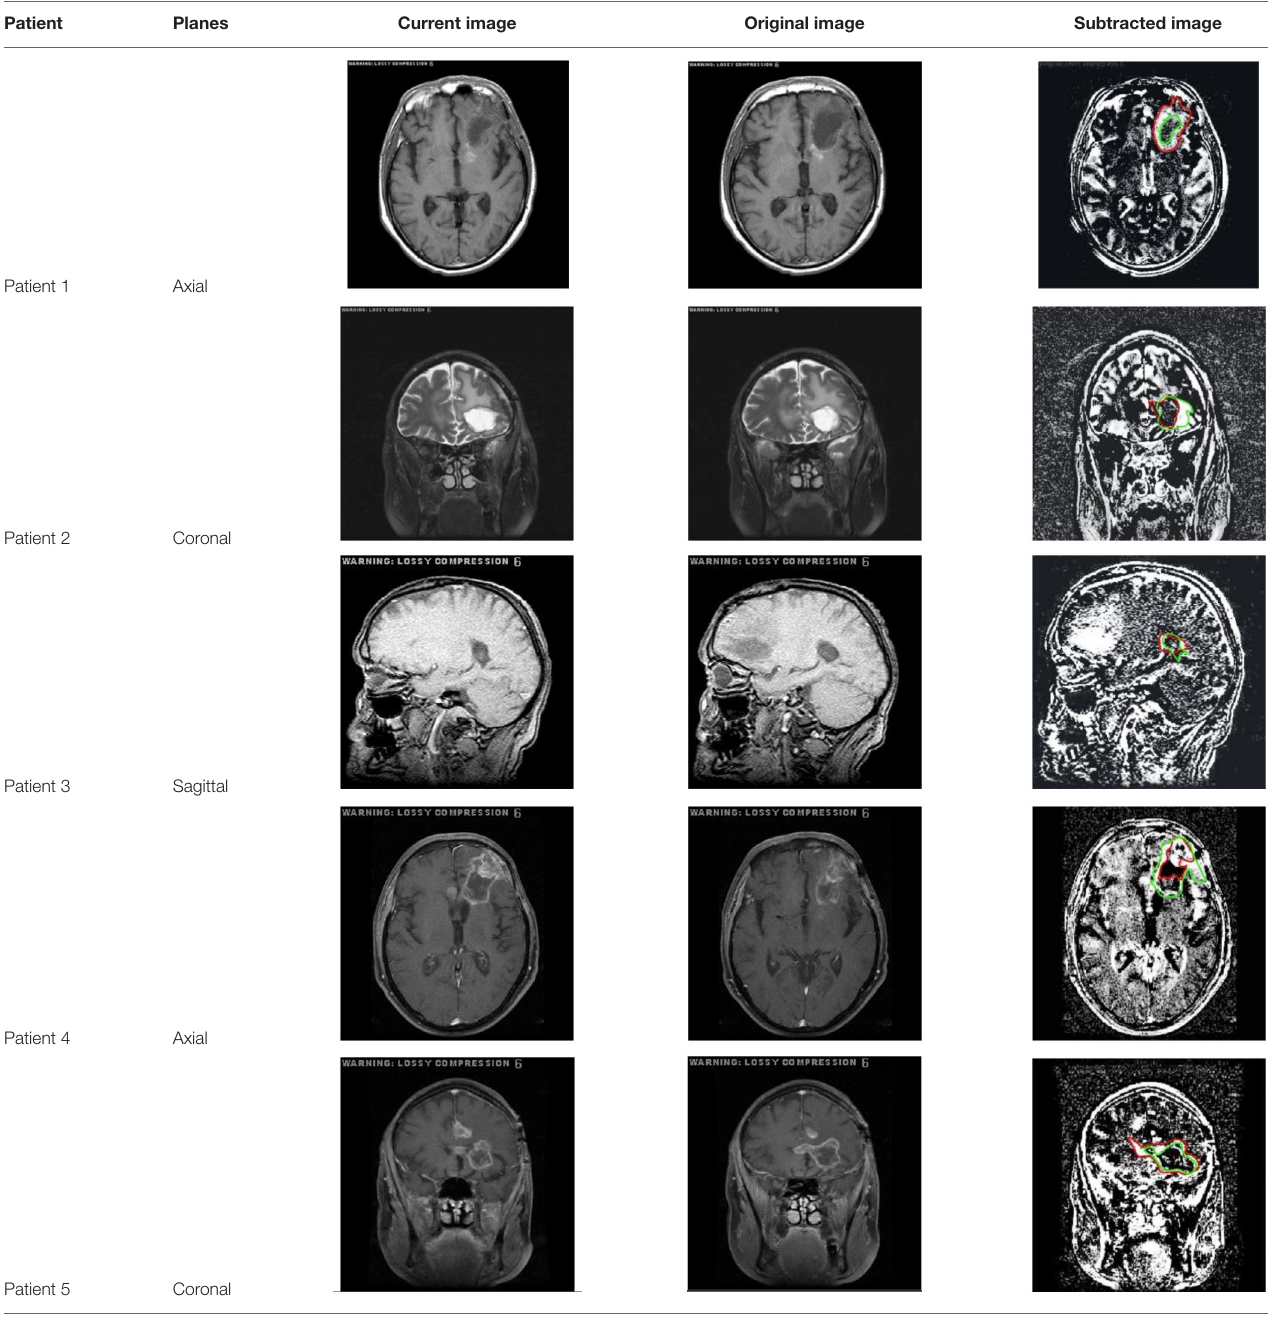
TABLE 2 | Results of registration on five